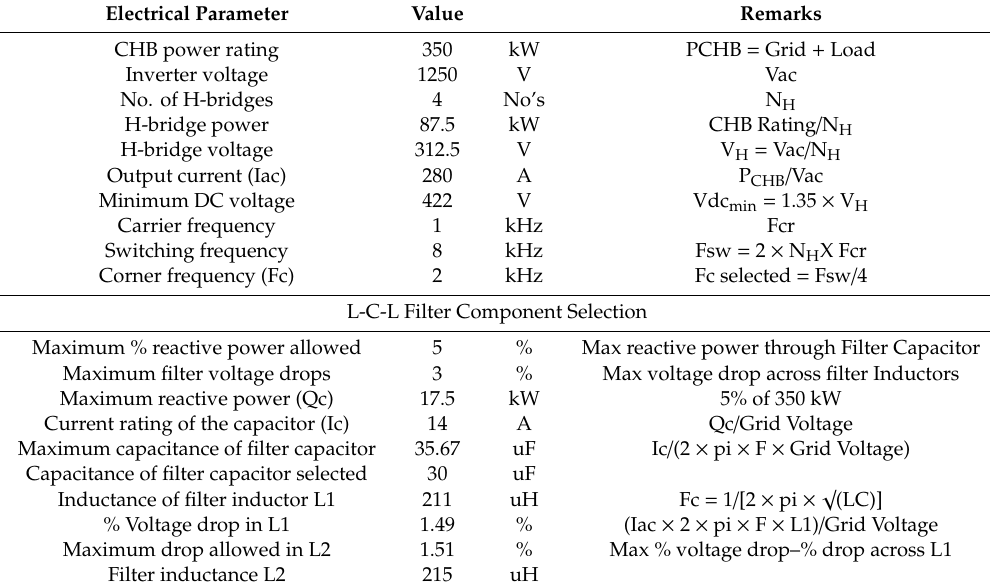
Table 1. Design calculations for CHB Inverter and L-C-L Filter.